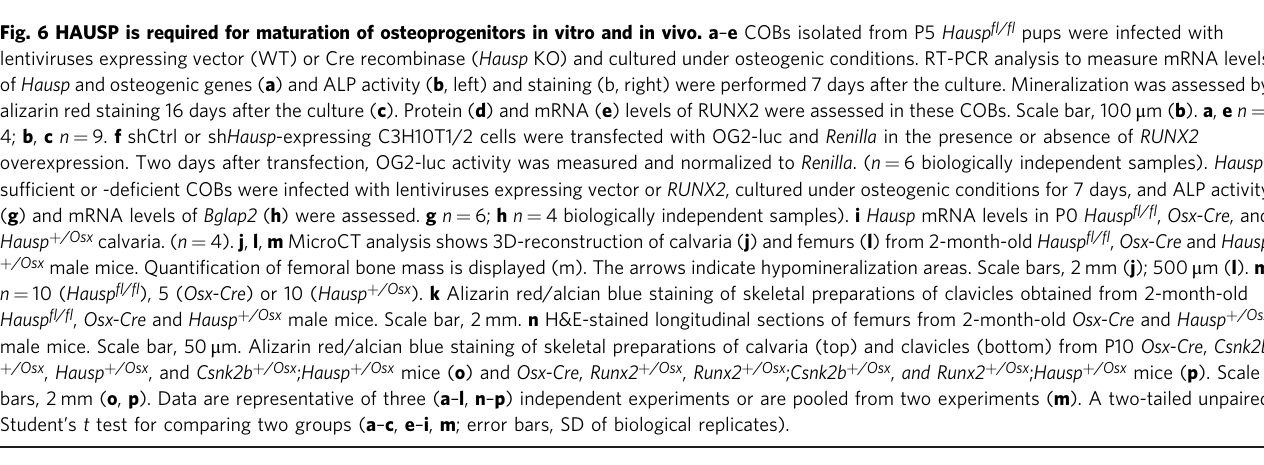
Fig. 6 HAUSP is required for maturation of osteoprogenitors in vitro and in vivo. a – e COBs isolated from P5 Hausp fl / fl pups were infected with lentiviruses expressing vector (WT) or Cre recombinase ( Hausp KO) and cultured under osteogenic conditions. RT-PCR analysis to measure mRNA levels of Hausp and osteogenic genes ( a ) and ALP activity ( b , left) and staining (b, right) were performed 7 days after the culture. Mineralization was assessed by alizarin red staining 16 days after the culture ( c ). Protein ( d ) and mRNA ( e ) levels of RUNX2 were assessed in these COBs. Scale bar, 100 μ m ( b ). a , e n = 4; b , c n = 9. f shCtrl or sh Hausp -expressing C3H10T1/2 cells were transfected with OG2-luc and Renilla in the presence or absence of RUNX2 overexpression. Two days after transfection, OG2-luc activity was measured and normalized to Renilla . ( n = 6 biologically independent samples). Hausp - suf fi cient or -de fi cient COBs were infected with lentiviruses expressing vector or RUNX2 , cultured under osteogenic conditions for 7 days, and ALP activity ( g ) and mRNA levels of Bglap2 ( h ) were assessed. g n = 6; h n = 4 biologically independent samples). i Hausp mRNA levels in P0 Hausp fl / fl , Osx-Cre , and Hausp + /Osx calvaria. ( n = 4). j , l , m MicroCT analysis shows 3D-reconstruction of calvaria ( j ) and femurs ( l ) from 2-month-old Hausp fl / fl , Osx-Cre and Hausp + /Osx male mice. Quanti fi cation of femoral bone mass is displayed (m). The arrows indicate hypomineralization areas. Scale bars, 2 mm ( j ); 500 μ m ( l ).